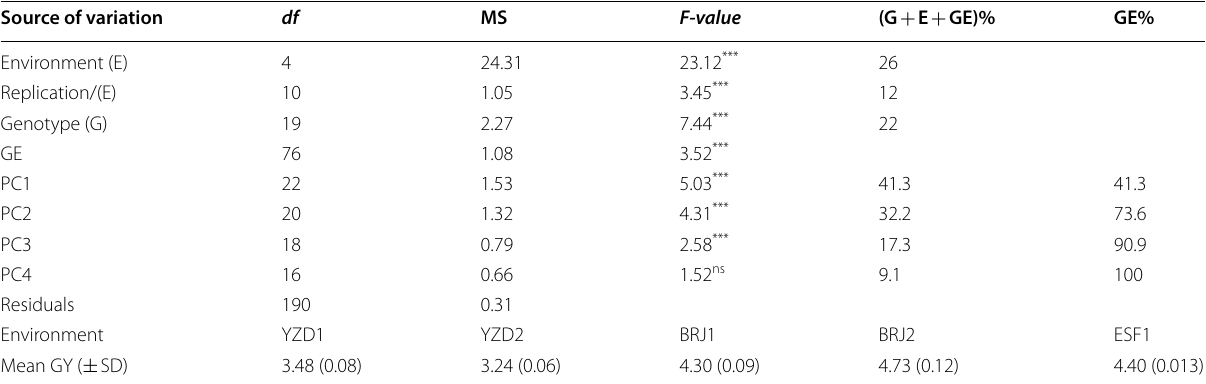
Table 3 AMMI analysis of variance for grain yield of the 20 investigated barley genotypes